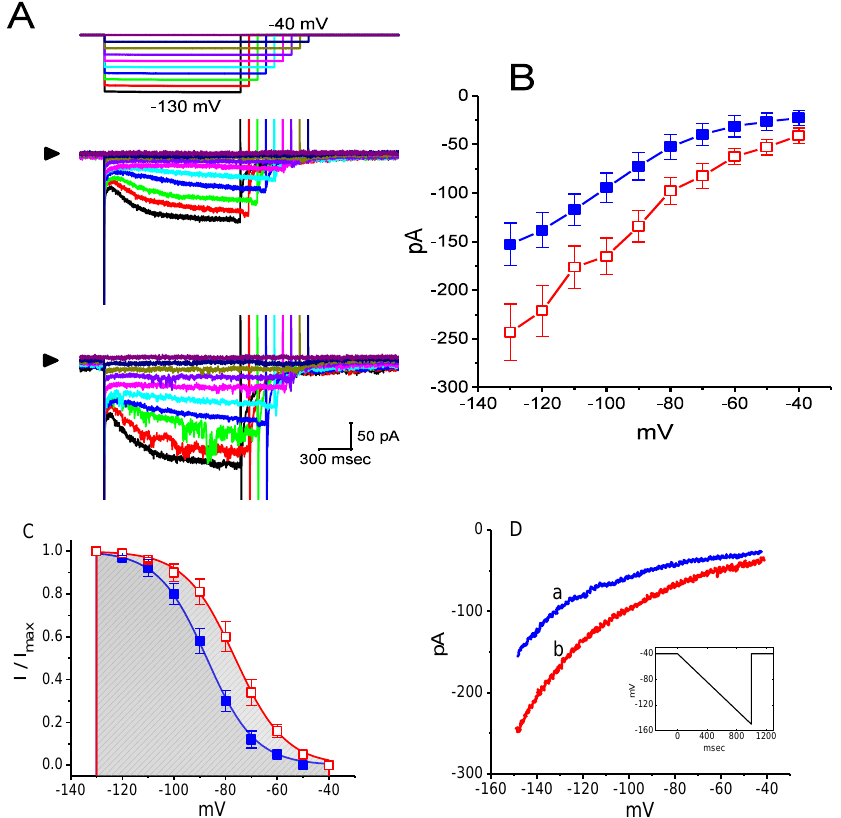
Figure 3. The inhibitory effects of OXAL on averaged I–V relationship of I h measured from GH 3 cells. In these experiments, we bathed cells in Ca 2+ -free Tyrode’s solution and filled the recording pipette by using K + -containing solution. ( A ) Representative whole-cell I h traces obtained in the absence (upper part) and presence of 3 μM OXAL (lower part). Arrowhead indicates zero current level and the uppermost part in ( A ) is the voltage protocol applied. ( B ) Averaged I–V relationships of I h measured at the end of hyperpolarizing pulses in the control (closed symbols) and during cell exposure to 3 μM OXAL (open symbols; each point indicates the mean ± SEM ( n = 9). ( C ) The effect of OXAL (3 μM) on the steady-state activation curve of I h (mean ± SEM; n = 9 for each point). ■ : control; □: in the presence of 3 μM OXAL. Continuous curves were well fitted by a Boltzmann function, as described in Materials and Methods. ( D ) I–V relationship of I h elicited in response to a long-lasting downsloping ramp pulse from −40 to −150 mV. Inset indicates the voltage protocol used. a: control; b: 3 μM OXAL.